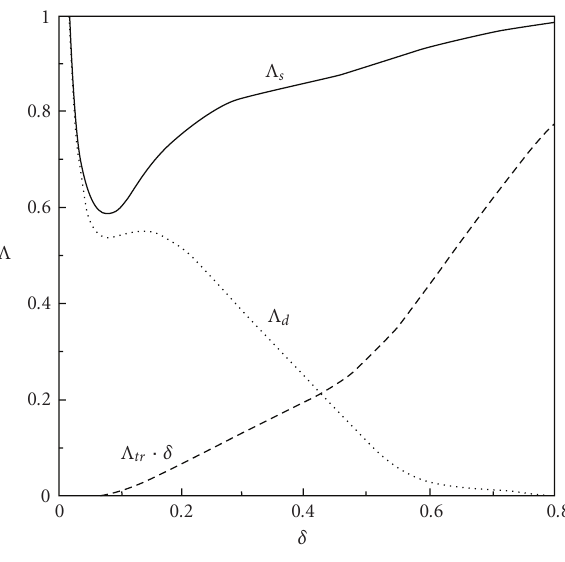
Figure 36: Normalized s -wave Λ s , d -wave Λ d , and transport Λ tr · δ coupling constants as a function of doping δ for t (cid:6) = 0 and J = 0. From [179,